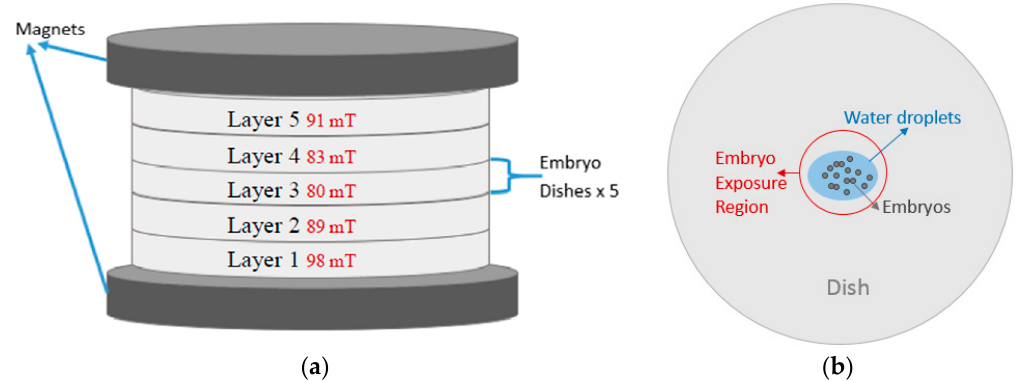
Figure 2. Magnet configuration for treated groups: ( a ) side view; ( b ) upper view.